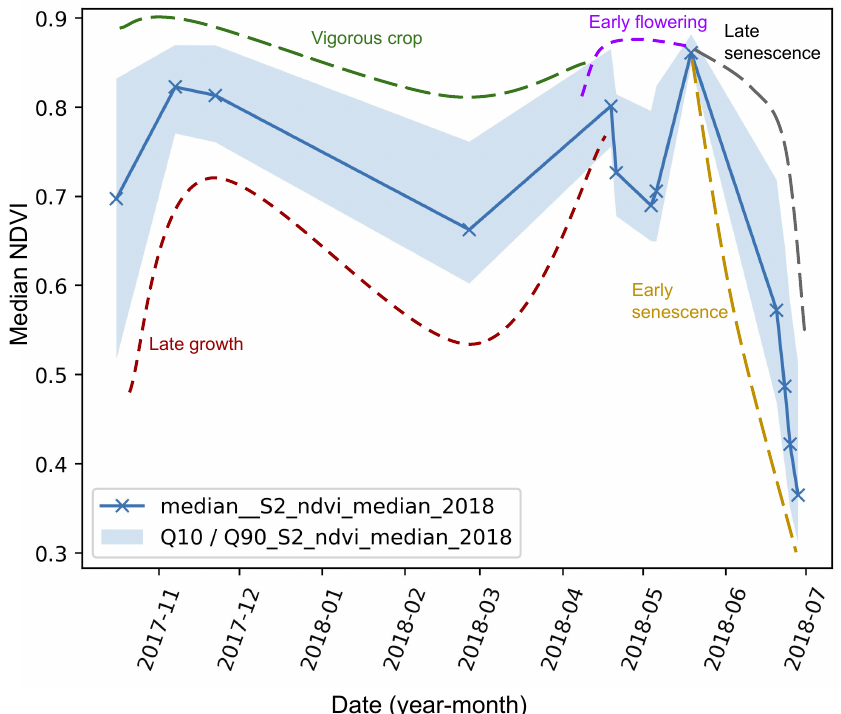
Figure 7. Illustration of the different growth anomalies that were detected and their potential influence on the median NDVI of the parcels (rapeseed crop). The blue line is the median value of the whole dataset. The blue area is filled between the 10th and 90th percentiles. Note that the labeling was conducted using all the S1 and S2 features (not only median NDVI).